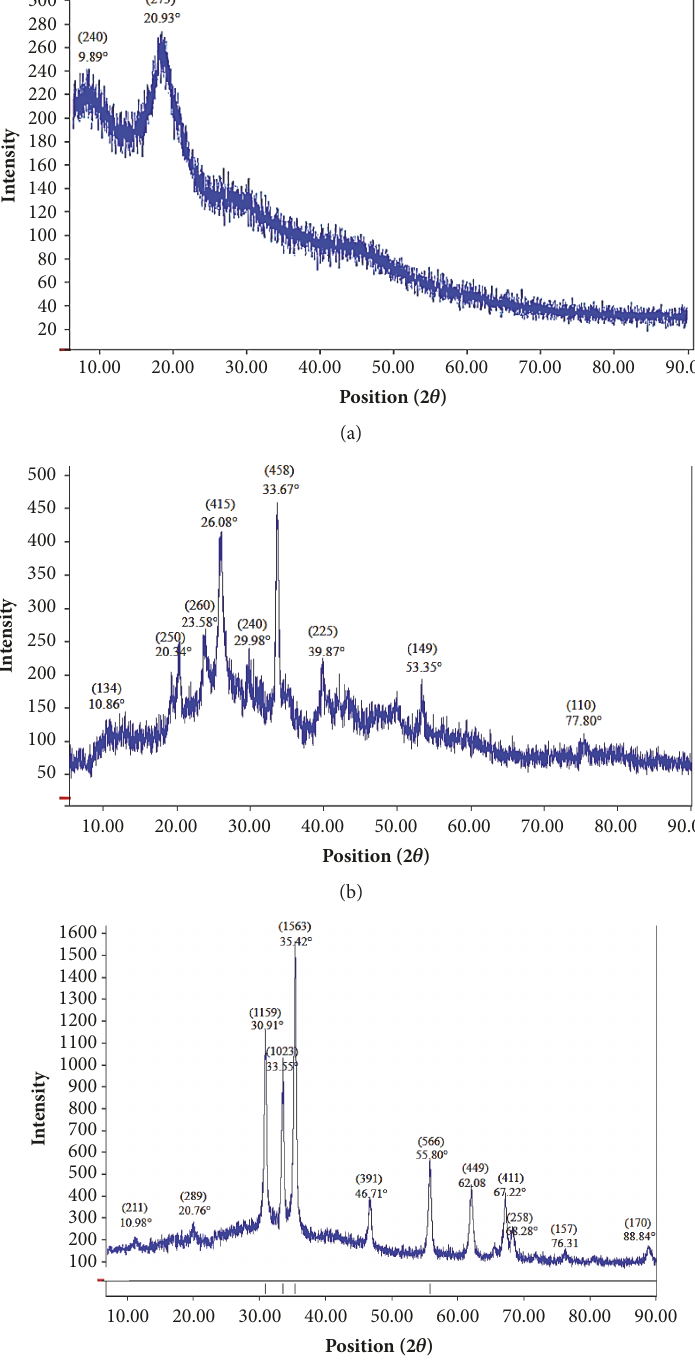
band at 1380 cm −1 is due to the COO- group in carboxylic −1 is attributed to the acid salt, while the peak at 1070 cm stretching vibration mode of the hydroxyl group. The band at 682 cm −1 is attributed to the vibration of O-Cu-O core groups. However, the peak at 493 is ascribed to Cu-O bond